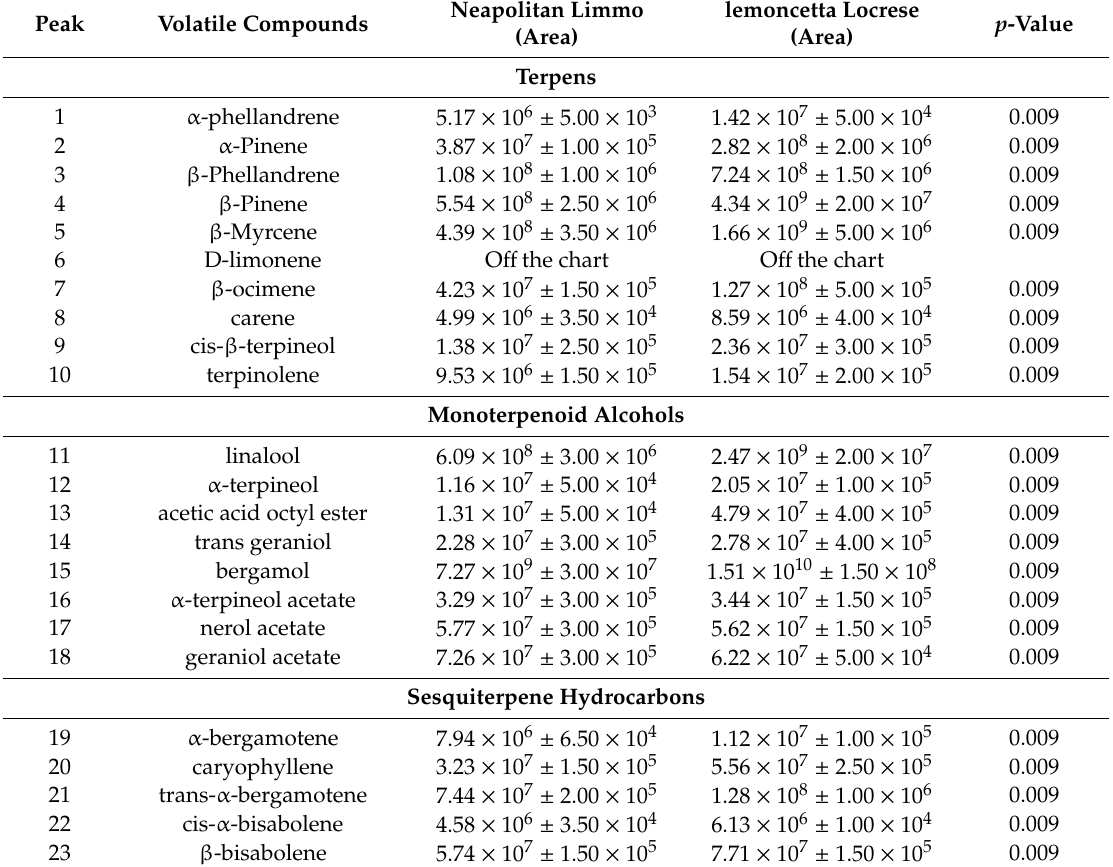
Table 5. Volatile compounds identified in the peels of Neapolitan limmo and lemoncetta Locrese. Data were expressed as average area of volatile compounds ± standard deviation. Values are significant at p <